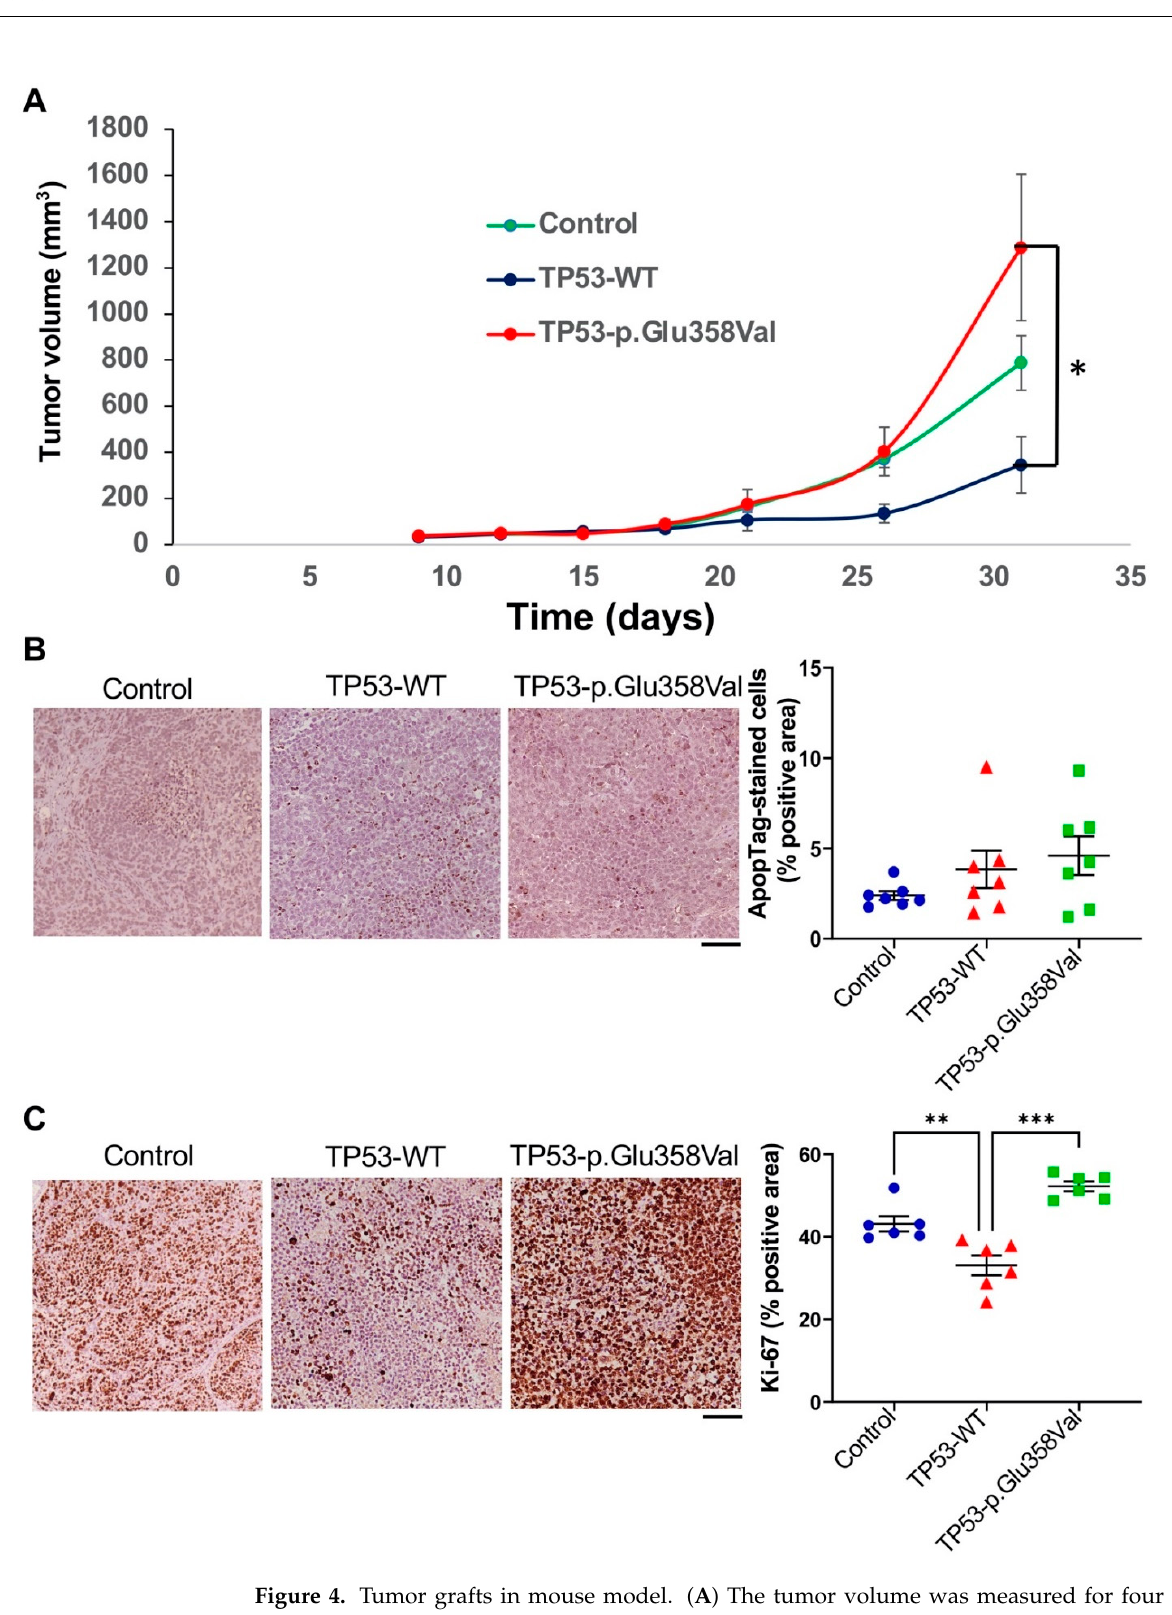
Figure 4. Tumor grafts in mouse model. ( A ) The tumor volume was measured for four weeks. The diagram shows the tumor growth curve of the mouse at the indicated days after subcutaneous implant of the tumor cells ( n = 5 per group). ( B ) H2172 tumors were sectioned and stained by ApopTag. ( C ) Ki-67 staining of H2172 tumor sections. Scale bar = 200 µm. * p < 0.05, ** p < 0.01, *** p < 0.001.